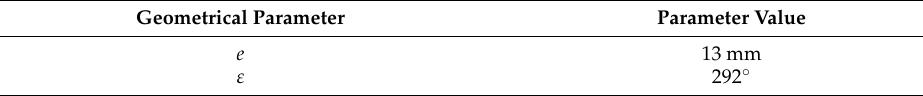
Figure 2. Comparison of cycloidal functions for θ 0 ~60° [31].